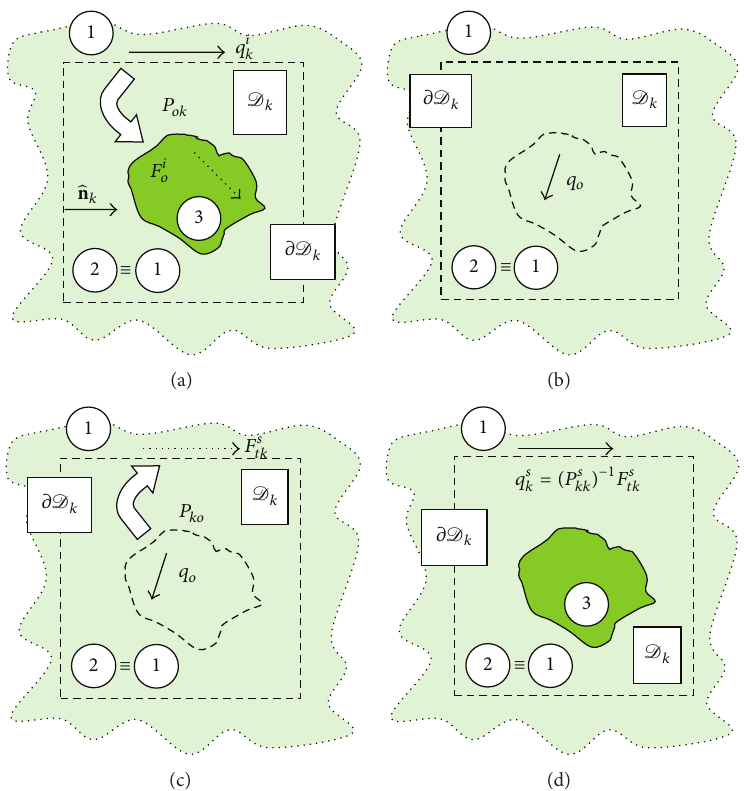
Figure 2: Derivation of the scattering operator of D 𝑘 in the case when host ( B ) and background ( A ) medium have the same EM properties. (a) The equivalent incident currents 𝑞 𝑖 𝑘 on 𝜕 D 𝑘 produce incident fields 𝐹 𝑖 𝑜 in the region occupied by the object; (b) the object “reacts” with polarization and/or magnetization currents 𝑞 𝑜 ; (c) the currents 𝑞 𝑜 produce scattered fields 𝐹 𝑠 𝑡𝑘 on 𝜕 D 𝑘 ; (d) the scattered fields are replaced with equivalent scattered currents 𝑞 𝑠 𝑘